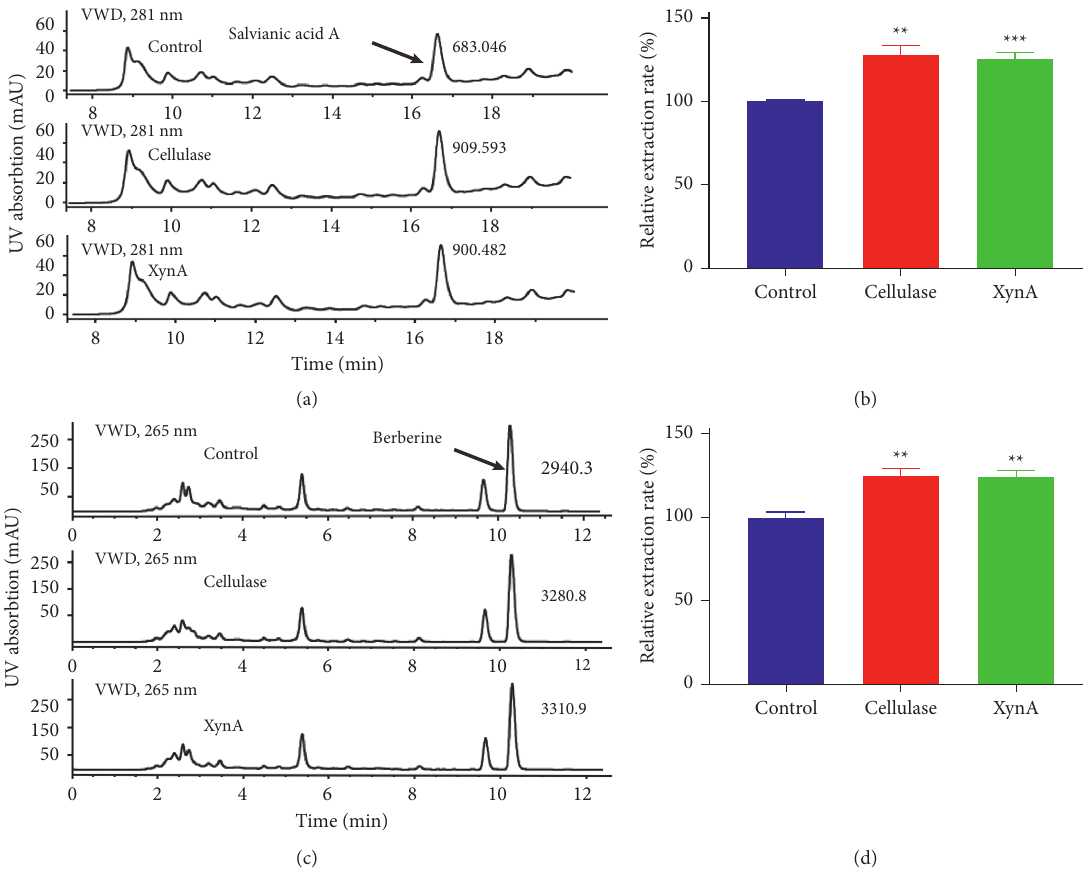
Figure 1: HPLC analysis of enzyme-assisted extraction using cellulase and XynA. (a) Different HPLC chromatograms with cellulose and XynA showing the extraction of salvianic acid A. (b) Effect of different enzymes on the extraction yield of salvianic acid A. (c) Different HPLC chromatograms with cellulose and XynA show the extraction of berberine. (d) Effect of different enzymes on the extraction yield of berberine. Extraction conditions were as follows: enzyme concentration was 20 U/g, time was 12 (h), pH was 6.0, and temperature was 60 ° C. Control, cellulase, and XynA are coloured blue, red, and green, respectively. The Y -axis shows the relative rates for extraction of salvianic acid A using different enzymes, as compared with the control group. The peak areas of two compounds were shown aside the peak. The data represent the mean ± S.D. ( n � 3). ∗∗ p < 0 . 01, ∗∗∗ p < 0 .